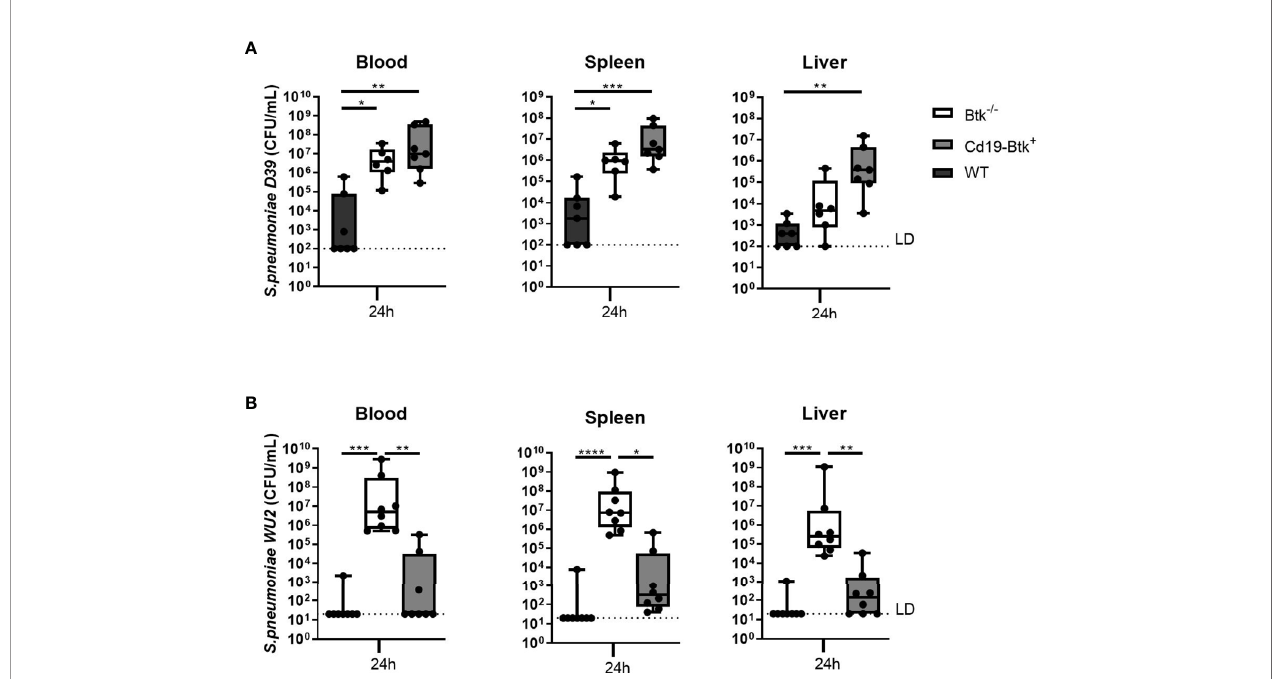
FIGURE 2 | Anti-pneumococcal natural antibodies confer protection against blood borne infection with pneumococcal strain WU2, but not with strain D39. (A) WT, Btk -/- and Cd19-Btk + mice were intravenously injected with 400 CFU D39 (n= 6-7 per group) or (B) 400 CFU WU2 (n=8). Mice were sacri fi ced 24 hours later and the bacterial loads in blood, spleen and liver were determined. Data are expressed as box- and whisker plots showing the smallest value, lower quartile, median, upper quartile and largest value. LD= limit of detection. *p < 0.05, **p < 0.01, ***p < 0.001, ****p < 0.0001, Kruskall-Wallis test with false discovery rate